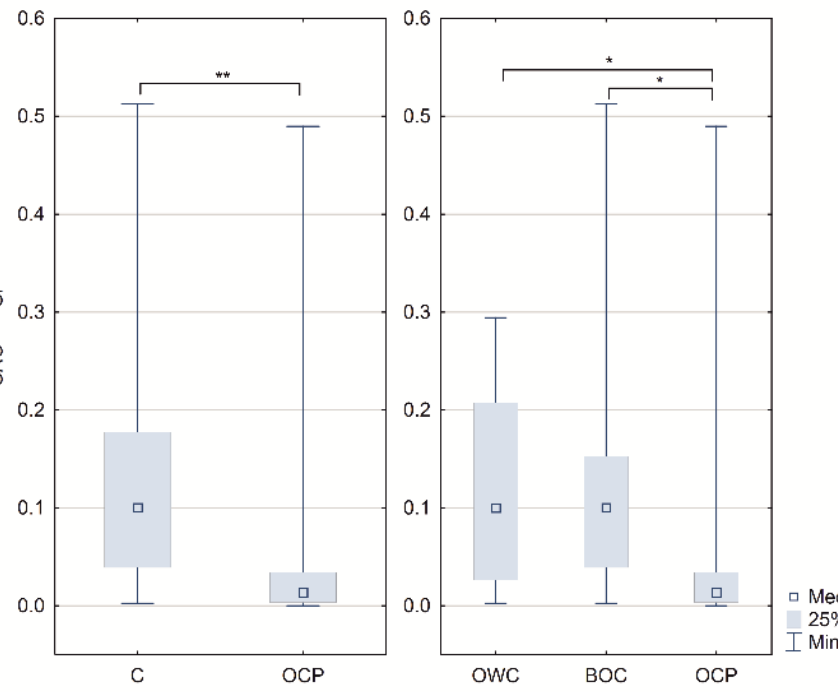
Figure 1. Boxplots of the SRC normalized concentration ratios in controls (C), ovarian cancer patients (OCP), ovarian tissue samples lack of any changes patients (OWC) and with benign noncancerous changes (BOC); * p < 0.05 and ** p < 0.01. Medians, interquartile range and p -values are shown